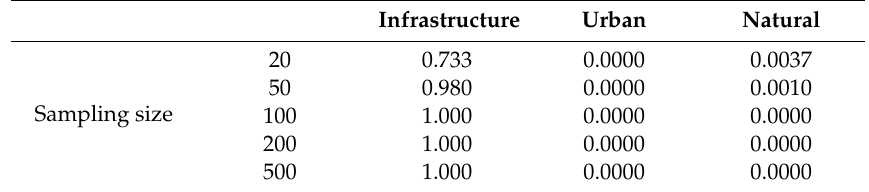
Table 7. Proportion of times that the null hypothesis has been rejected for the QC1 in each study case. Infrastructure Urban